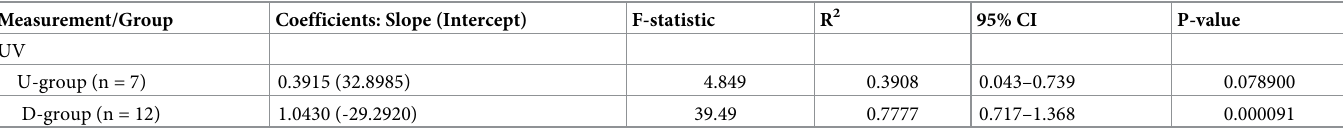
Table 3. A correlation on glucose levels between the anterior chamber and blood in Study 2 subjects.